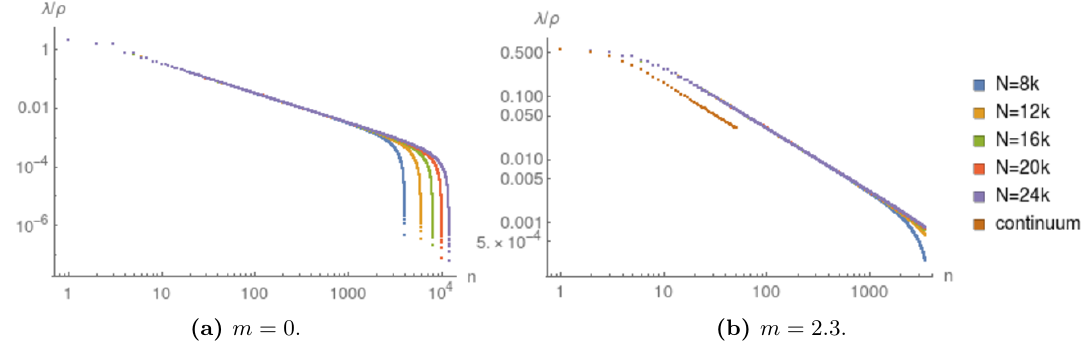
Figure 10. Log-log plot of the positive eigenvalues of i (cid:1) at T = 1, in 2d de Sitter. In the massive case on the right we plot the largest 3500 positive eigenvalues and the corresponding continuum eigenvalues from the (cid:12)nite T mode comparison results of